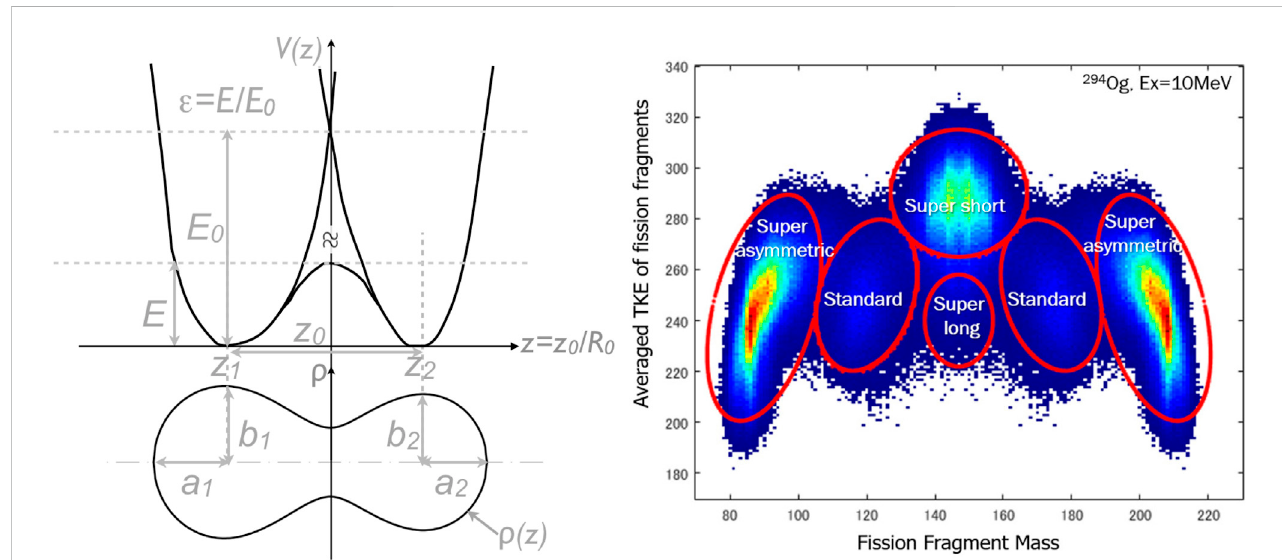
FIGURE 1 Left: The lower part shows the shape of a 236 U nucleus calculated by the TCSM. The upper part is the corresponding potential. Right: TKE distribution of fi ssion fragments with our fi ssion modes in the case of 294 Og as compound nucleus at E x = 10